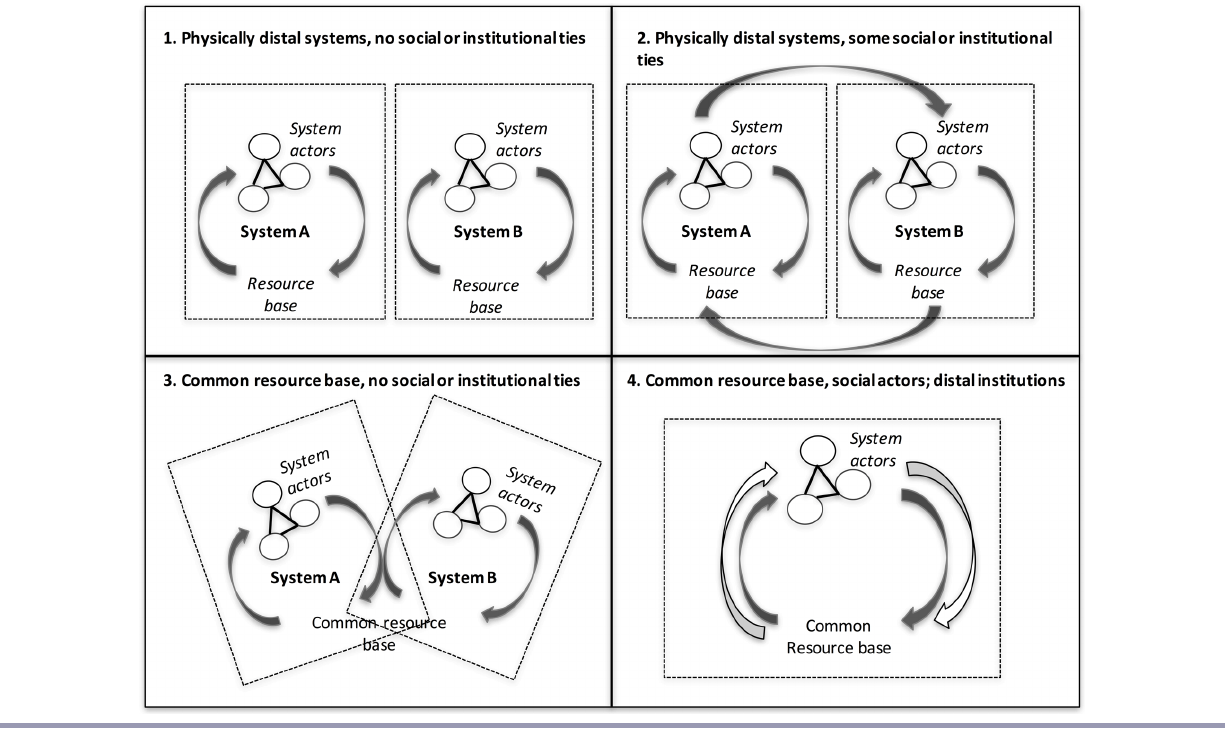
Fig. 1 . Typology of possible initial conditions in telecoupled interactions. In each quadrant, we depict a caricature of a social-ecological system, composed of interactions between resource base and a social system. Each analytically discrete social-ecological system is signaled by a rectangle boundary, within which a constellation of actors participates in the use of a resource base. Their actions over the resource, and the resource response to these actions, i.e., flows of goods or resource units, are governed through institutional arrangements (signaled by